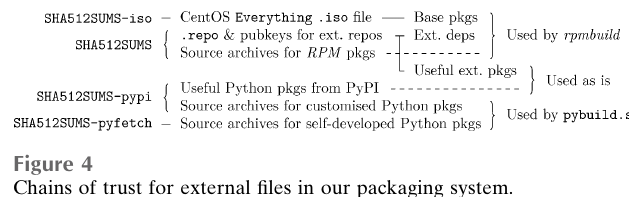
Figure 4 Chains of trust for external files in our packaging system.